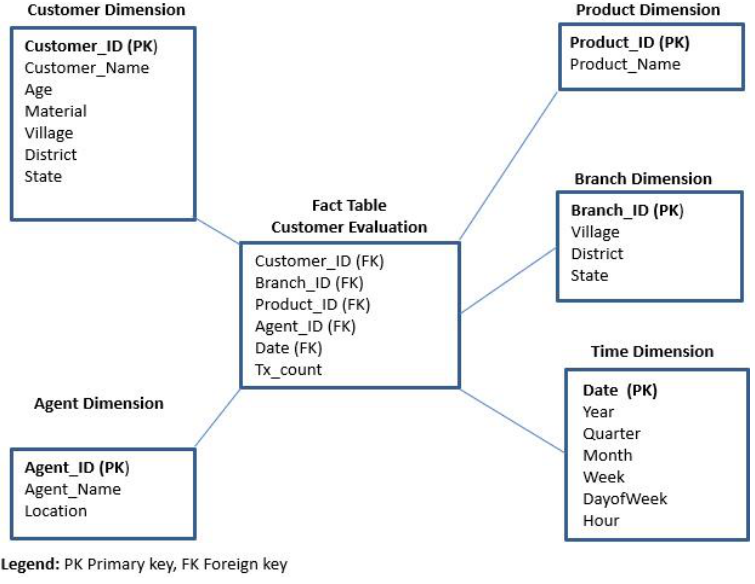
Fig. 7 Requirement development process for Operational